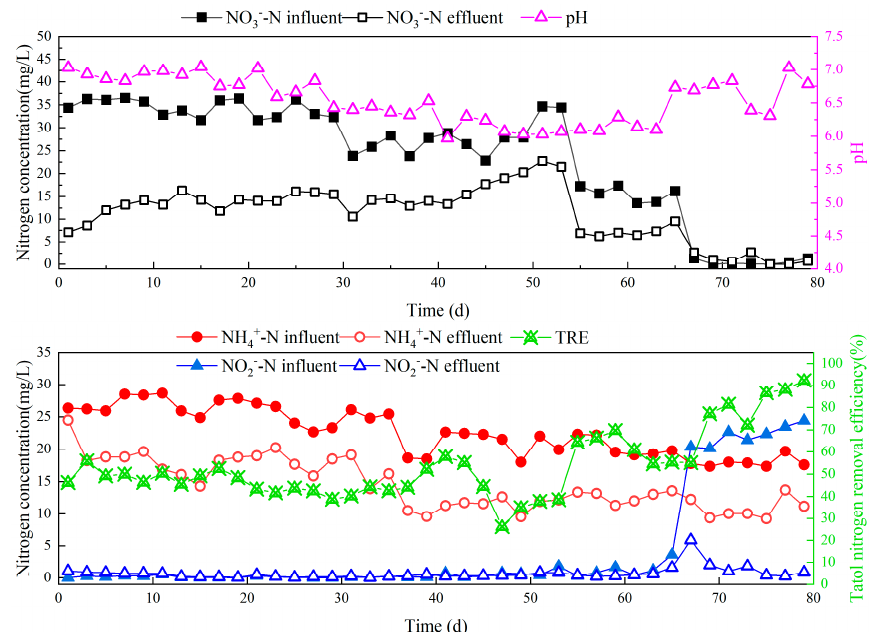
Figure 3. Variations of water quality and nitrogen removal e ffi ciency during the S 0 -SADN phase.